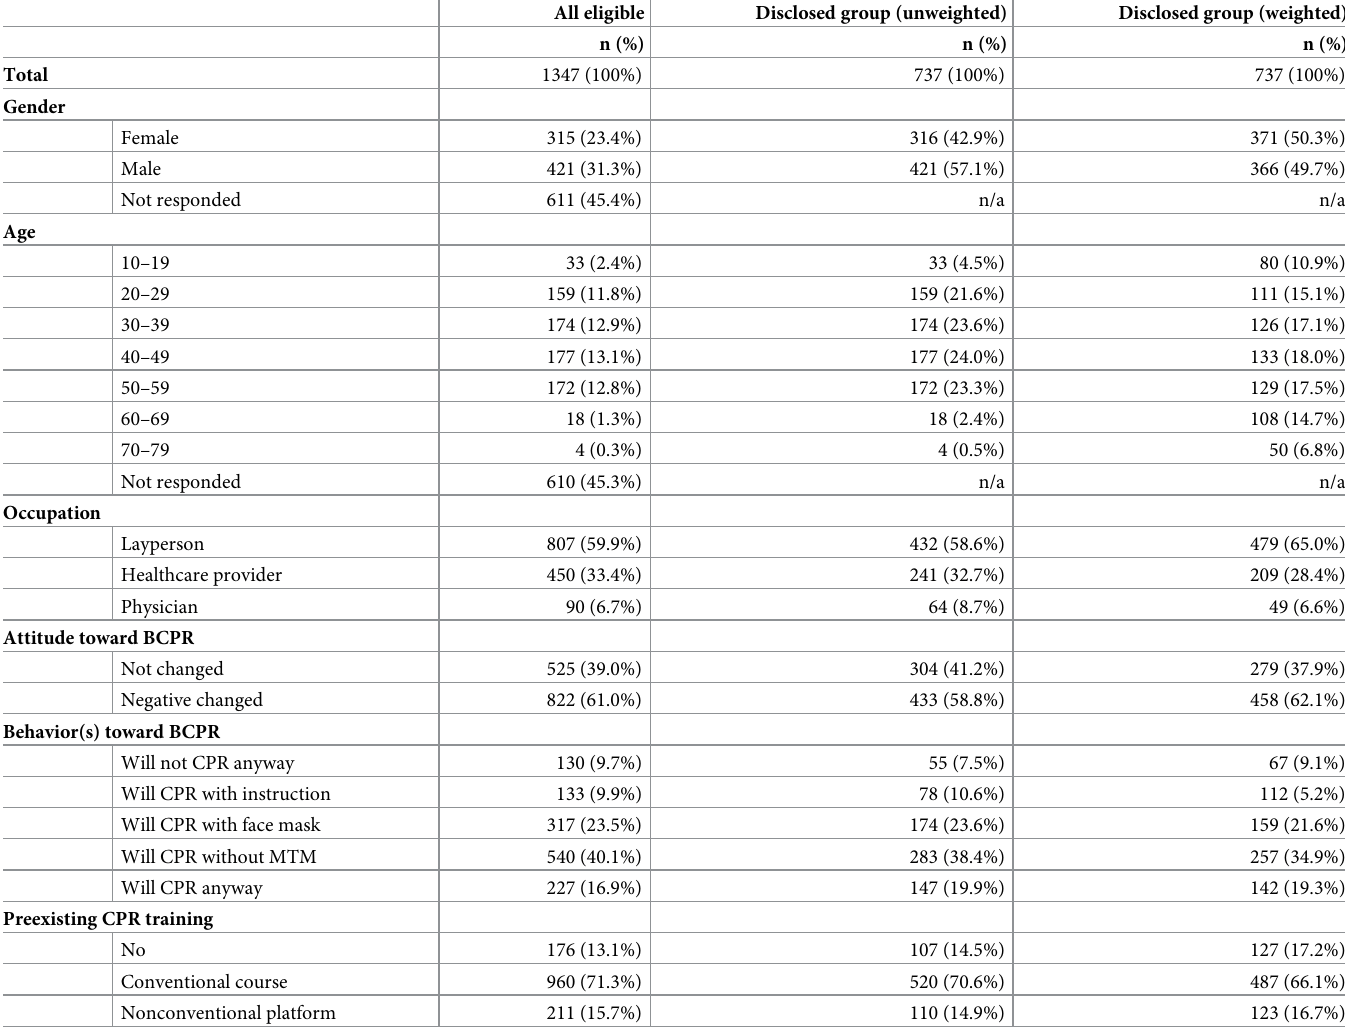
Table 1. Characteristics of survey respondents: All eligible, unweighted disclose, and weighted disclose